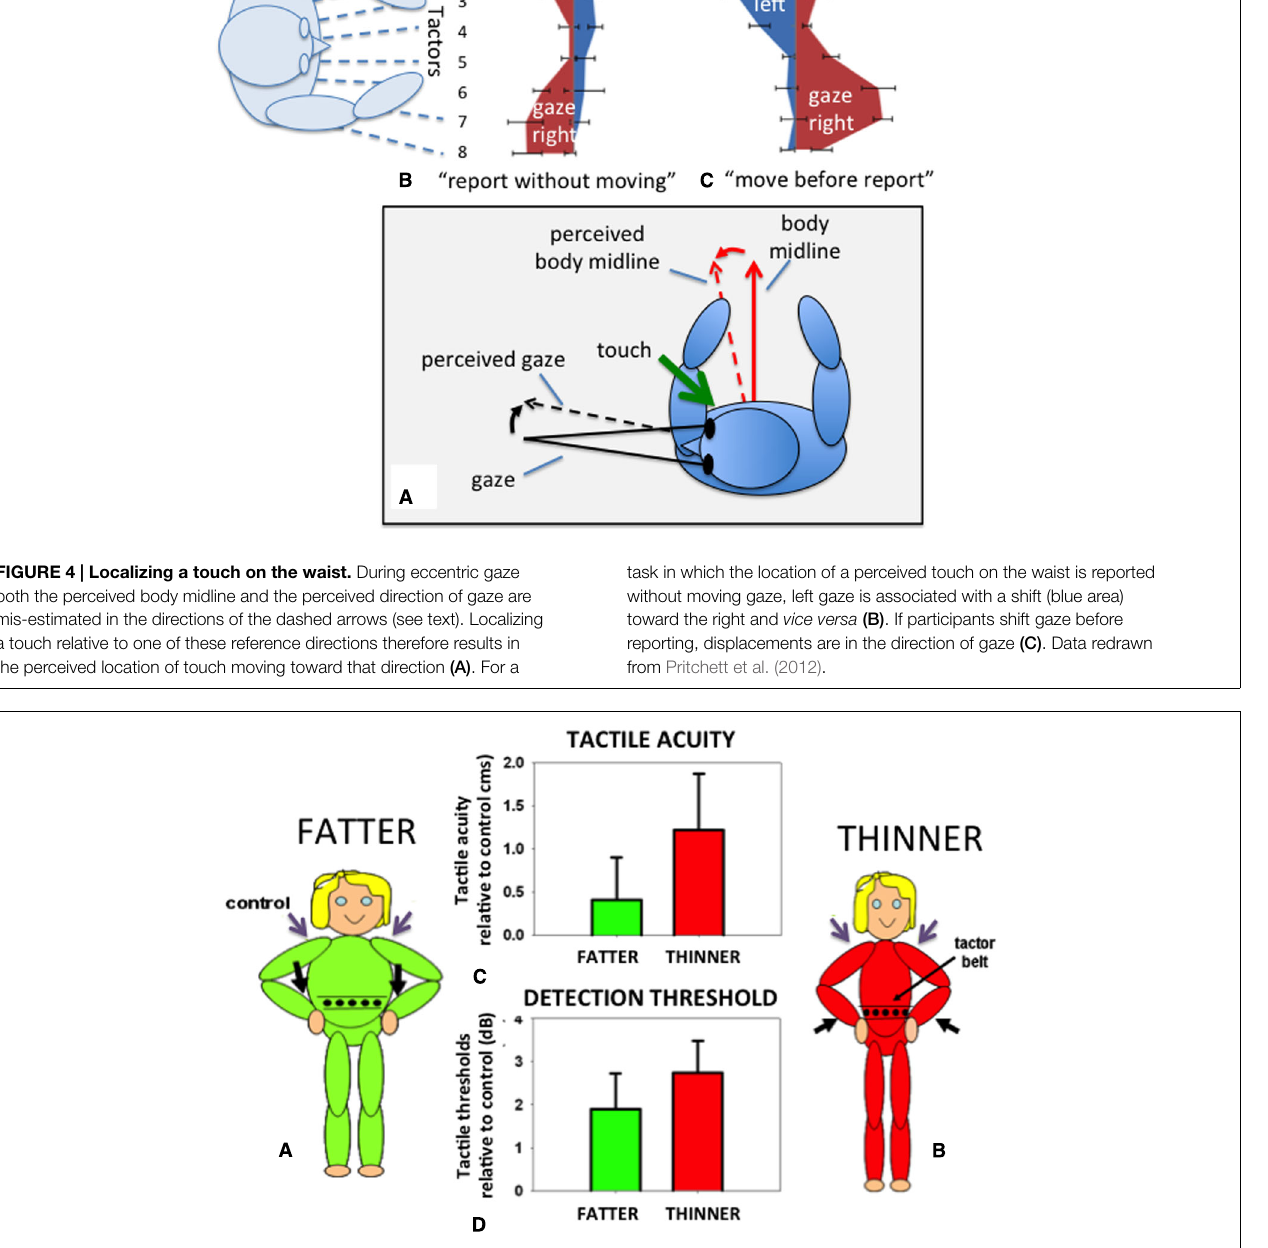
FIGURE 5 | Participants were made to feel fatter (A) or thinner (B) by vibrating their wrist tendons (black arrows). Tactile acuity (C) and average sensitivity (D) on the waist (expressed relative to control trials